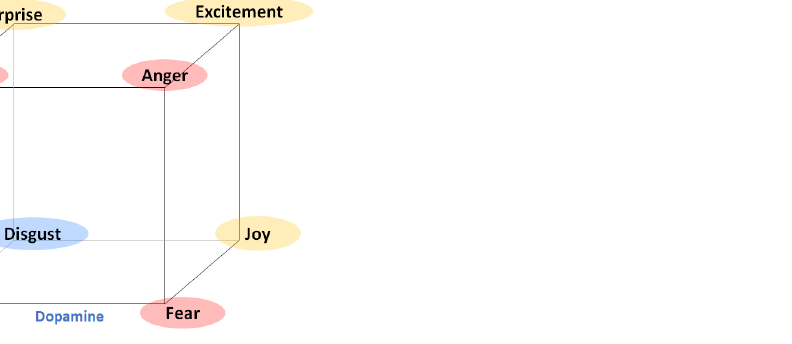
Figure 2. Loveheim cube showing correspondence among catecholamines and emotions (based on [12]).